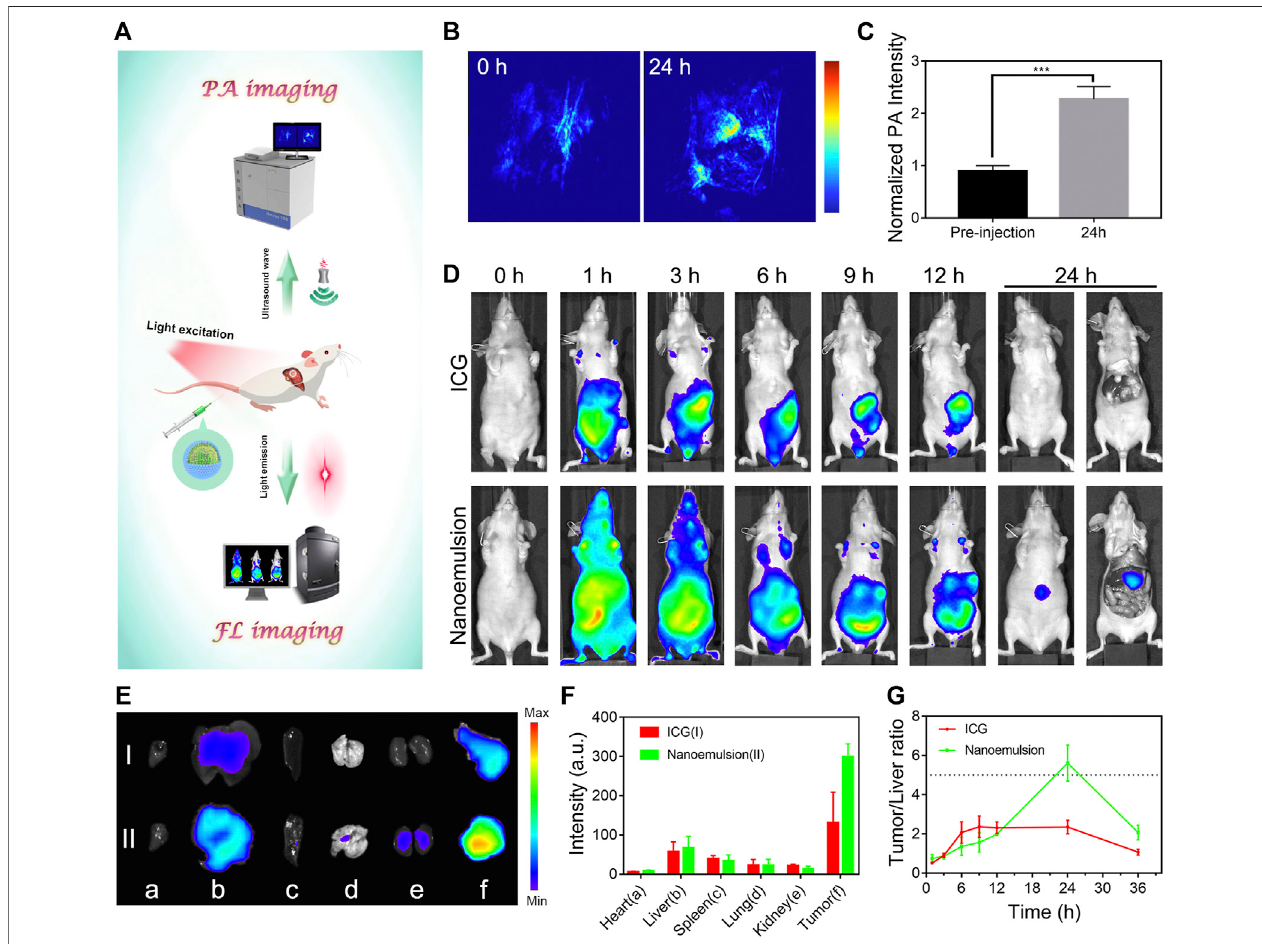
FIGURE 3 | (A) Schematic illustration of the optical diagnosis of nanoemulsion in orthotopic HCC-bearing mice. (B) PA images and (C) intensity analysis of tumor sitesfromnanoemulsion-treatedmice. (D) FLimagesoforthotopicHCC-bearingmicemodelaftertailveininjectionofICGsolutionornanoemulsion. (E) Exvivo tissueFL image and (F) FL intensity (I: ICG group; II: nanoemulsion group) of HCC-bearing mice after different treatments at 24 h post-injection. The a, b, c, d, e, and f represent heart, liver, spleen, lung, kidney, and tumor. (G) FL signal ratio of tumor-to normal liver tissue at various time